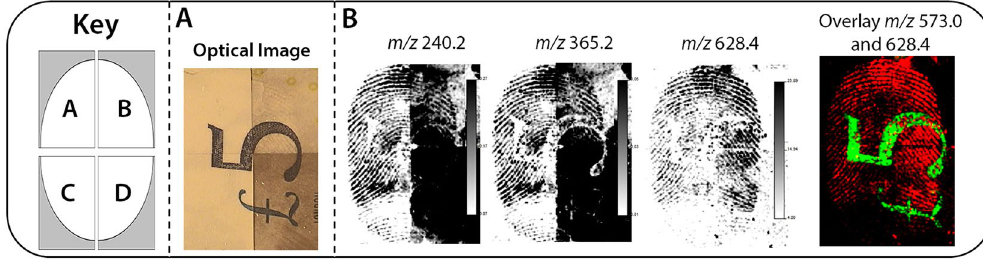
Figure 5. MALDI MSI analysis of a latent ungroomed fingermark deposited onto a polymer banknote following development using conventional FETs. The key indicates the FET used on each section ( A) - No enhancement, ( B ) CAF followed by black powder suspension (Wetwop TM ), ( C ) CAF, ( D ) (Wetwop TM ). Panel (A) shows an optical image following enhancement of the fingermark, whereby ridge detail was only observed in section ( B ). Panel (B) shows the subsequent MALDI MS images, indicating an improvement in ridge detail for sections ( B , C) when selecting an unidentified species and tetracosadienoic acid [M + H] + ( m/z 240.2 and m/z 365.2) and full fingermark reconstruction when selecting an unidentified species ( m/z 628.4). The overlapping image depicts a strong background signal obtained from the ‘£5’ security